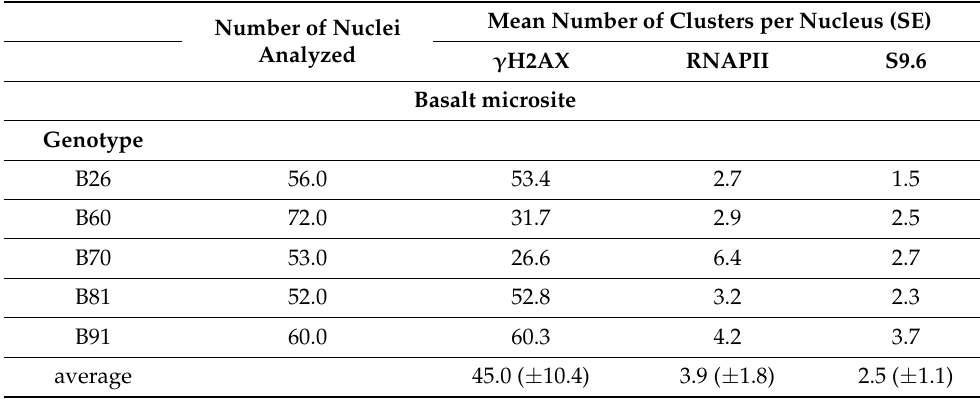
Figure 8. Number of clusters of γ H2AX ( A ), RNAPII ( B ), and S9.6 ( C ) in interphase nuclei in individual plants of the Basalt (B) and the Terra Rossa (TR) microsites of the Tabigha population. Average number of clusters of γ H2AX ( D ), RNAPII ( E ), and S9.6 ( F ) in the B and TR microsites. Standard error bars are represented. Table 2. Mean number of γ H2AX, RNAPII, and S9.6 clusters in interphase nuclei in plants of the Basalt (B) and Terra Rossa (TR) microsites of the Tabigha